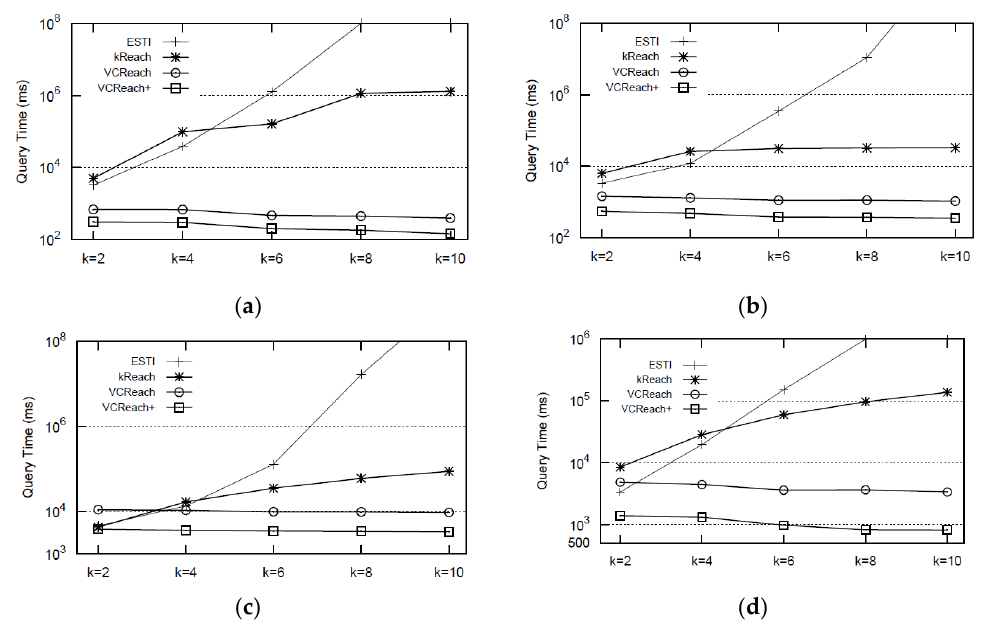
Figure 4. Comparison of query time (ms) on dense graphs ( deg abg > 10), where ( a ) shows results